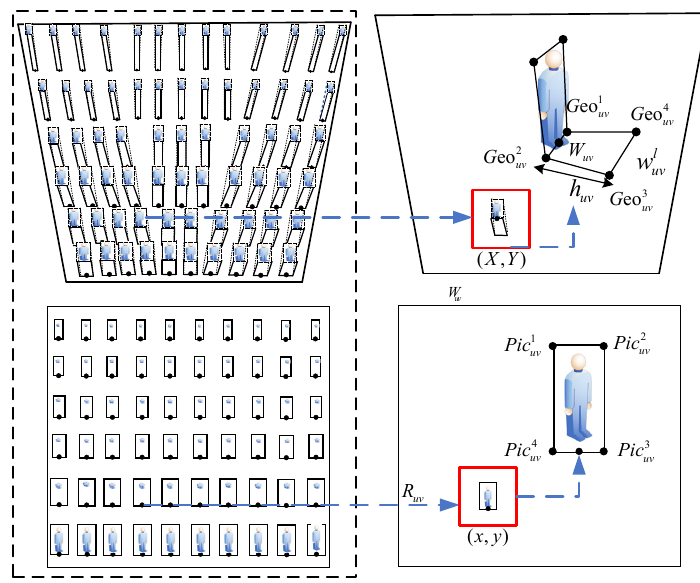
Figure 5. Threshold 𝑅 (cid:3048)(cid:3049) calculation.